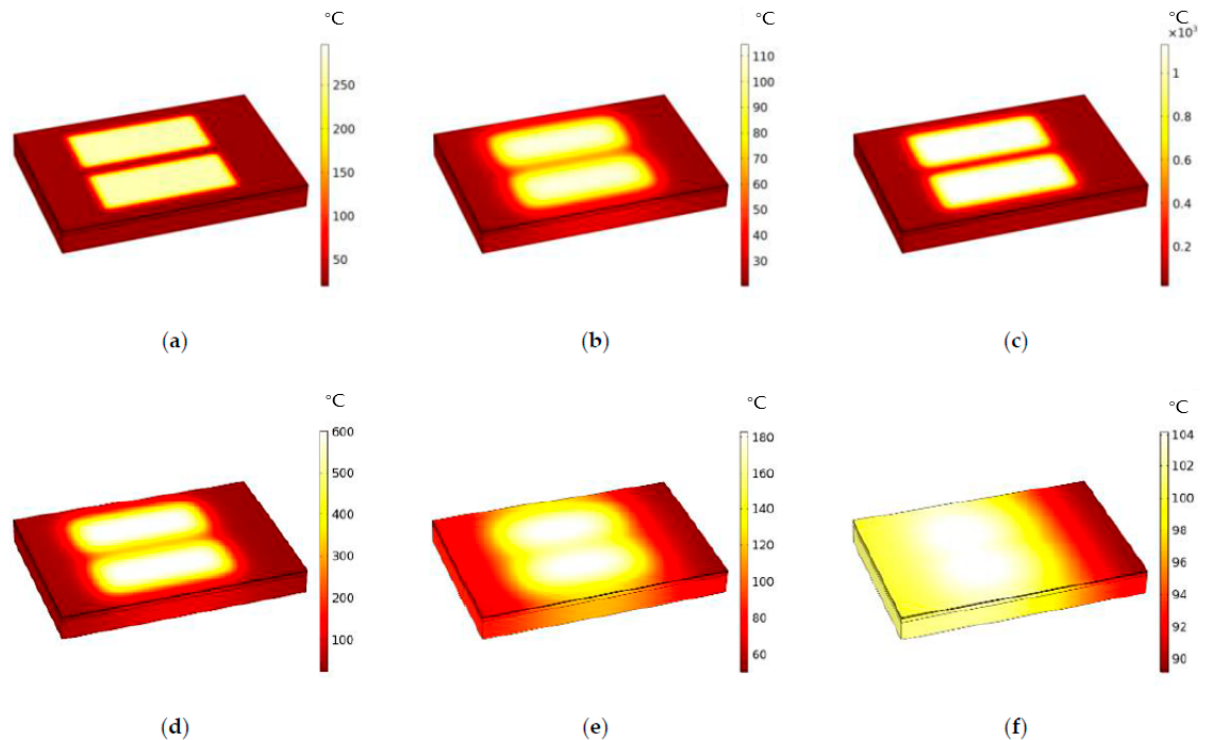
Figure 5. The temperature changes of the selected key point at different times at the different driving voltages.